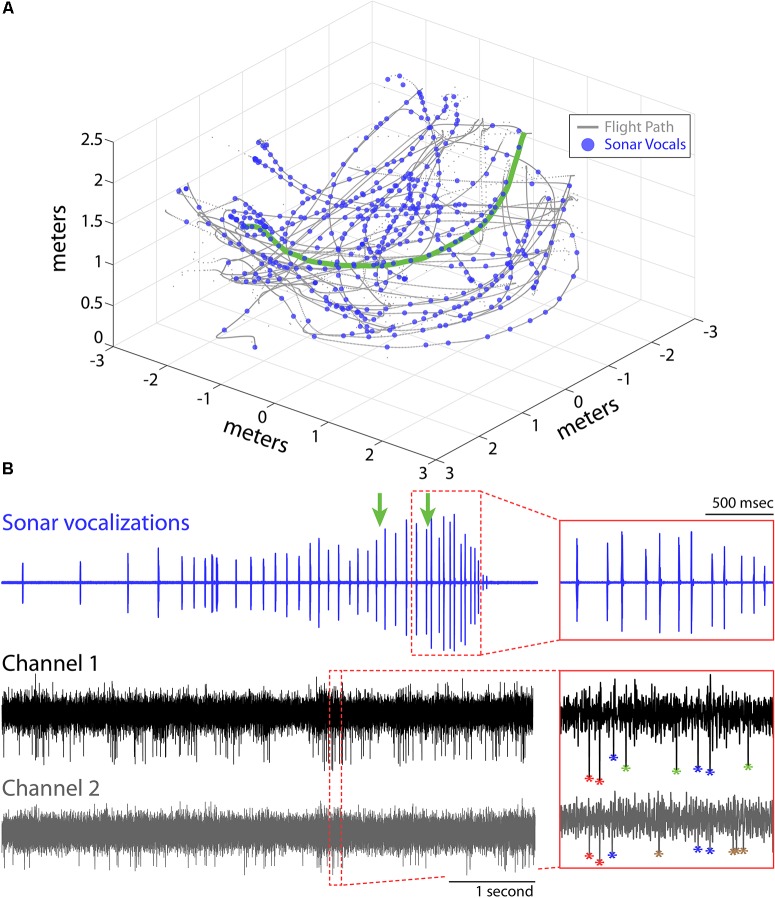
Experimental setup and recordings. (A) Flight trajectories (gray) and vocalizations (blue circles) during one experimental session for Bat 1. The bat navigated around obstacles (not shown) in a large flight room (6 m × 6 m × 3 m) while recordings of hippocampal activity, sonar vocalizations, and the animals’ flight paths were collected. (B) Example of sonar vocalizations (top), and two adjacent recording channels (middle and bottom) for one flight trial for the experimental session shown in (A) (selected flight trajectory shown in green in A). Green arrows mark the times when the bat passed the two flight obstacles in this trial. Insets show time expanded portions identified by the red, dotted boxes (top, vocals; bottom, neural). Action potentials from different neurons are color coded with different asterisks in bottom inset panel.